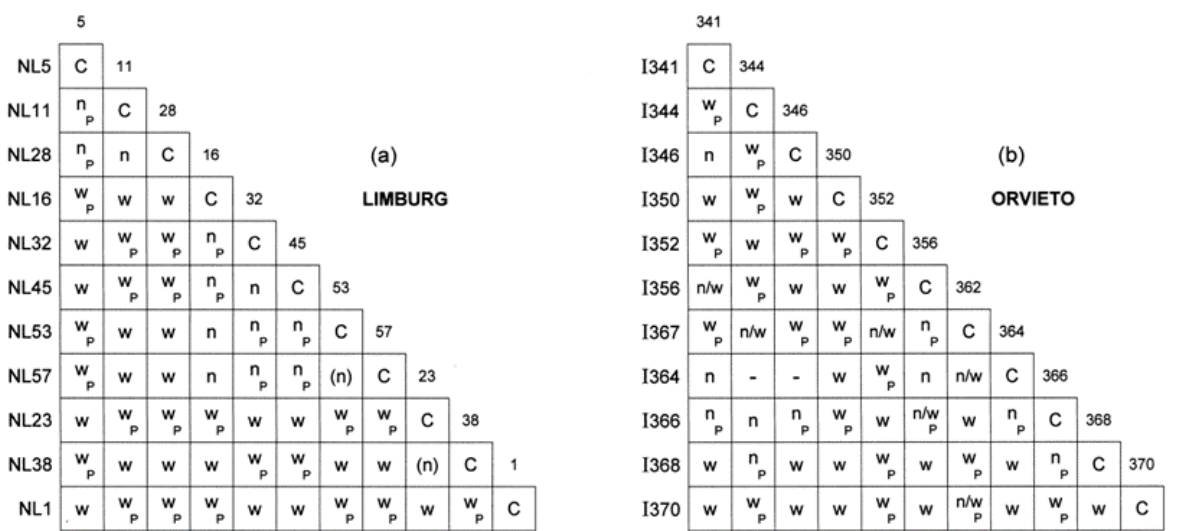
Figure 3. Vegetative compatibility reactions between paired O. novo-ulmi subspecies hybrid isolates from the Limburg ( a ) and Orvieto ( b ) populations. C, compatible reaction; W, incompatible ‘wide’ barrage reaction; n, incompatible ‘narrow’ barrage reaction; P, perithecia formed (sexually compatible pairing); n/w, unclear whether an n- or a w-reaction; (n), weaker n-reaction; -, no data.